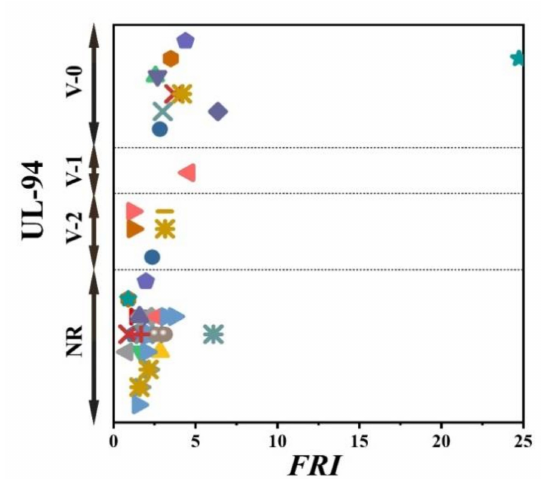
Figure 2. FRI values versus UL-94 test results. Symbols are indicative of di ff erent types of phosphorus flame retardant (FR) used. The vertical intervals in each category, i.e., V-0, V-1, V-2, and NR, are schematically representative of the amount of additive used. For example, two data distinguished by di ff erent symbols having the same or very close FRI values (horizontal quantity) in a given category (e.g., V-1) may have di ff erent vertical quantities, e.g., both reveal V-1 behavior in the UL-94 test, but the upper contains more FR in Polypropylene (PP).